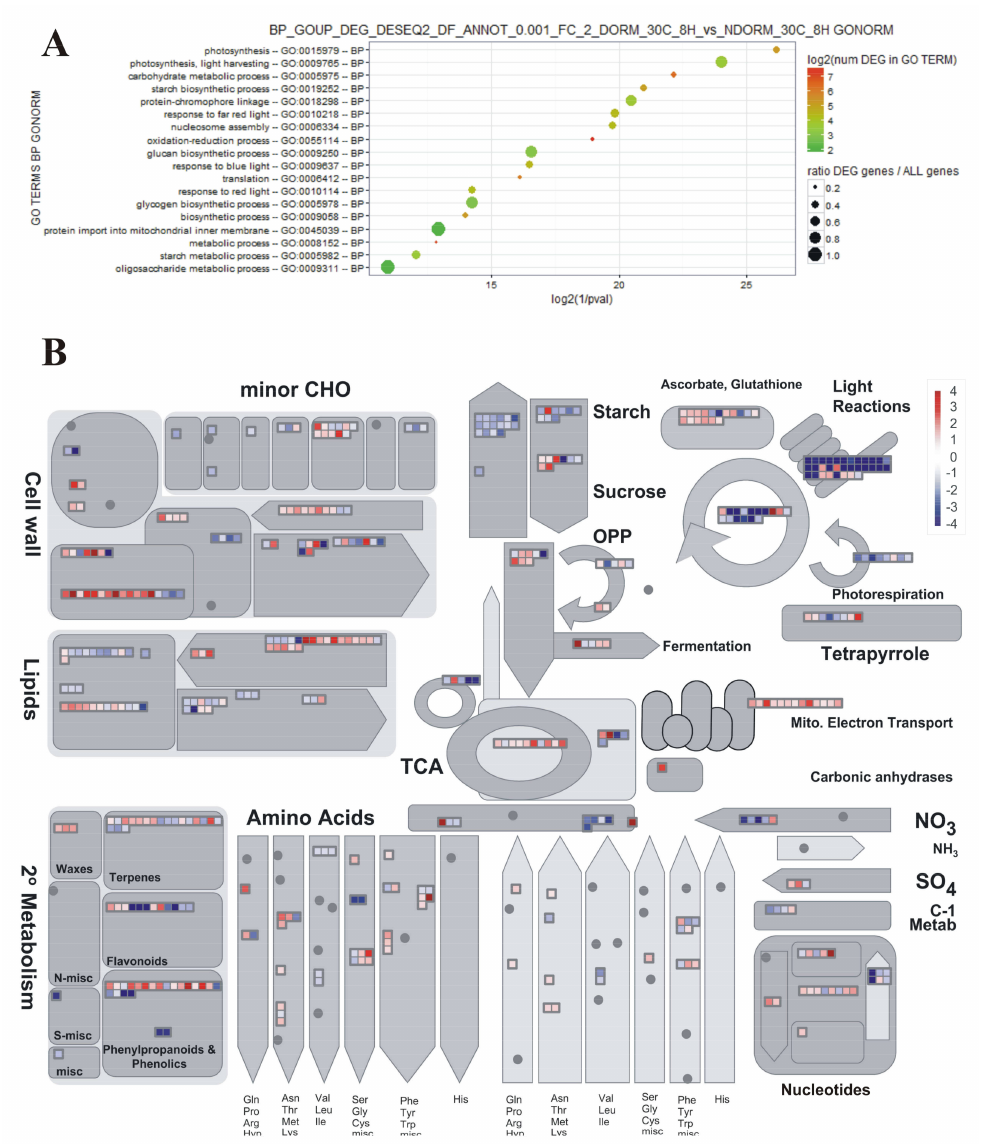
Figure 1. Comparison between gene expression in D and ND seeds incubated in water for 8 h at 30 ◦ C. ( A ) GO term enrichment analysis for the Biological Process domain. The GO terms for which DEGs resulted enriched are reported on the y-axis, whereas the transformed GO enrichment probability is reported on the x-axis (higher values of the log 2 (1/probability value) transformation correspond to higher significance). The color of each spot indicates the number of DEGs that matched the GO term (log 2 -transformed), whereas the size of each spot shows the proportion of DEGs that matched the GO term with respect to all the rice genes that pertain to that GO term. ( B ) MapMan Metabolism overview. Single DEGs are represented by elementary squares grouped in functional BINs, and their color indicates the relative expression level in this contrast (in terms of log 2 FC, color scale on the right upper corner), with red showing relative higher expression in ND seeds and blue in D